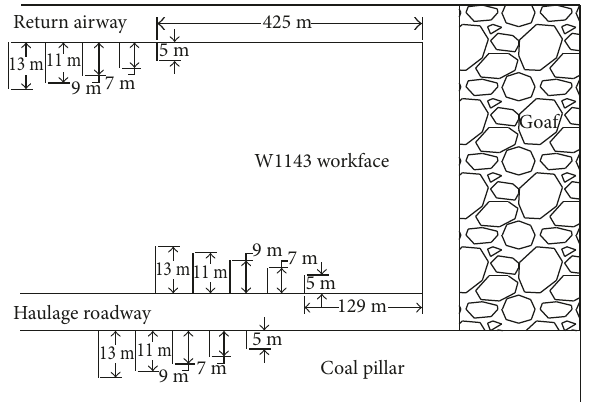
Figure 15: Layout diagram of borehole stress detector.